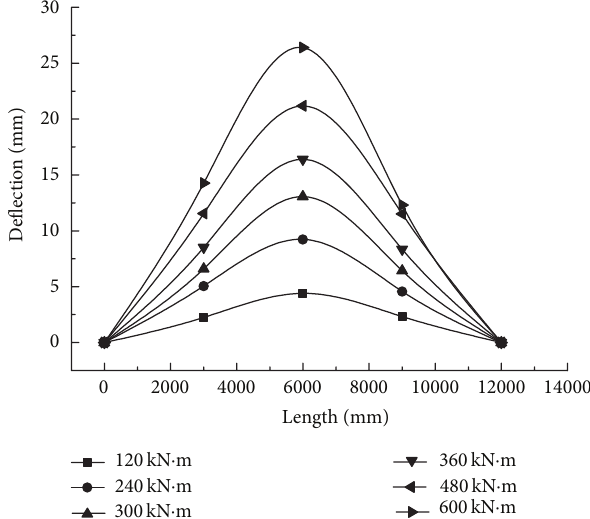
Figure 13: Deflection of Side-A.